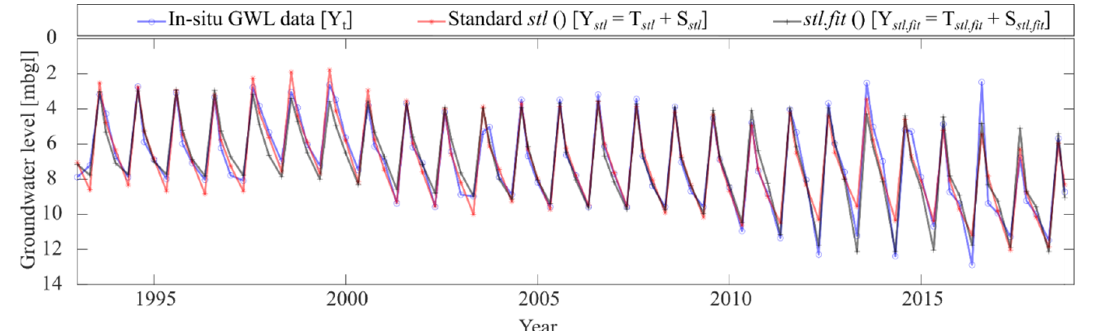
Figure 8. Time series of GWL from 1993 to 2018. The line in blue represents the observed GWL from the in situ data, and the lines in red and black are the fitted GWL using standard stl() auto and stl.fit() models, respectively.